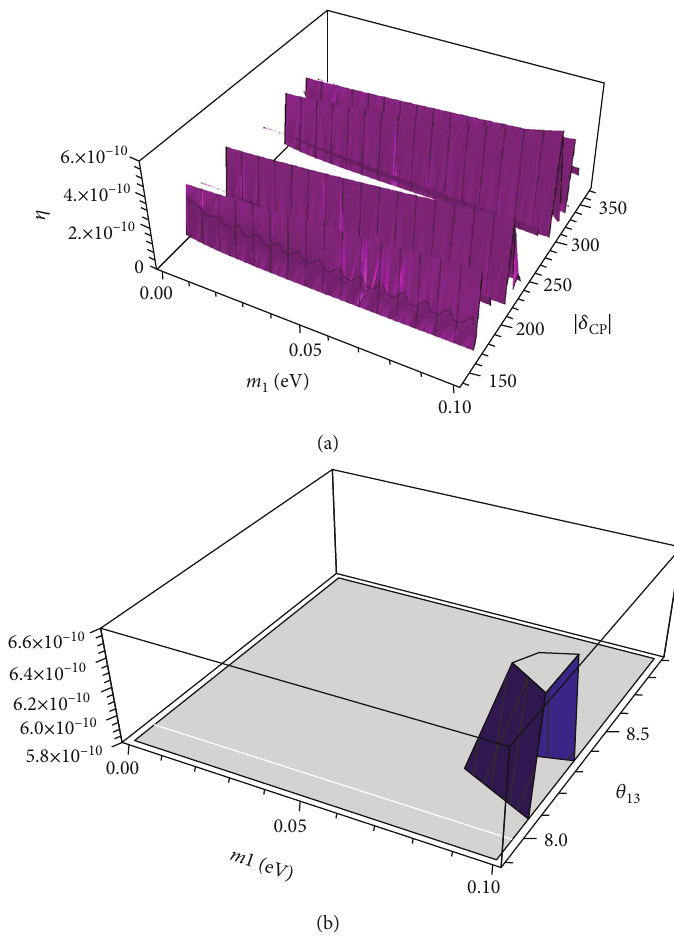
Figure 2: Predictions in the broken μ − τ symmetry model for normal ordering: (a) the three-dimensional plot of preferred values of the ð m Þ plane for the best fi t values of θ , δ = 8 : 41 of Δχ 2 = 9 : 5 w/o SK-ATM [14] (in the light of recent ratio of the baryon to photon density 1 CP 13 bounds 5 : 8 × 10 − 10 < η < 6 : 6 × 10 − 10 ) as a result of contribution of the type I seesaw mechanism to neutrino mass matrix. Similarly, (b) shows Þ plane, for the best fi t value of δ the three-dimensional plot of favourable values of the ð m , θ = 222 ° of Δχ 2 = 6 : 2 [14] (in the light of 1 13 CP recent ratio of the baryon to photon density bounds 5 : 8 × 10 − 10 < η < 6 : 6 × 10 − 10